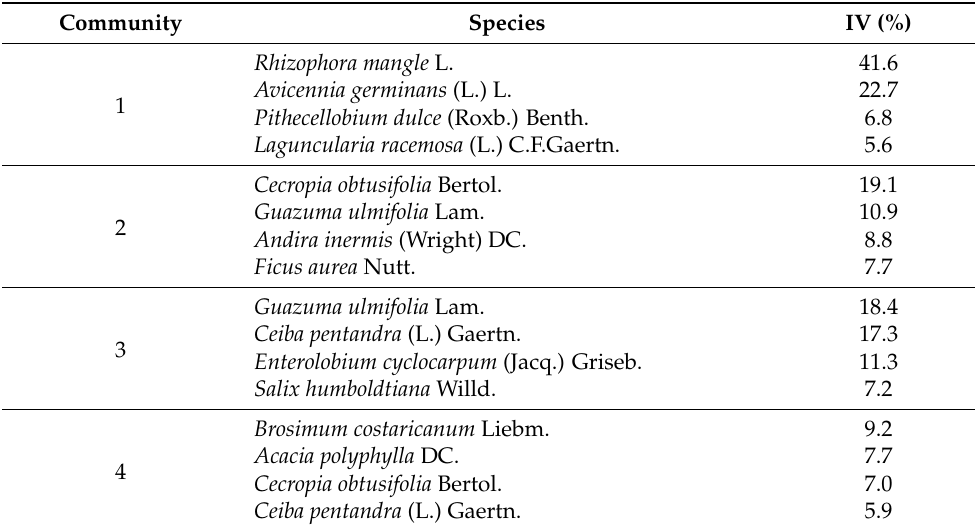
Table 2. Importance values (IVs) of dominant species of the riparian tree communities along the Acom é riverbank.